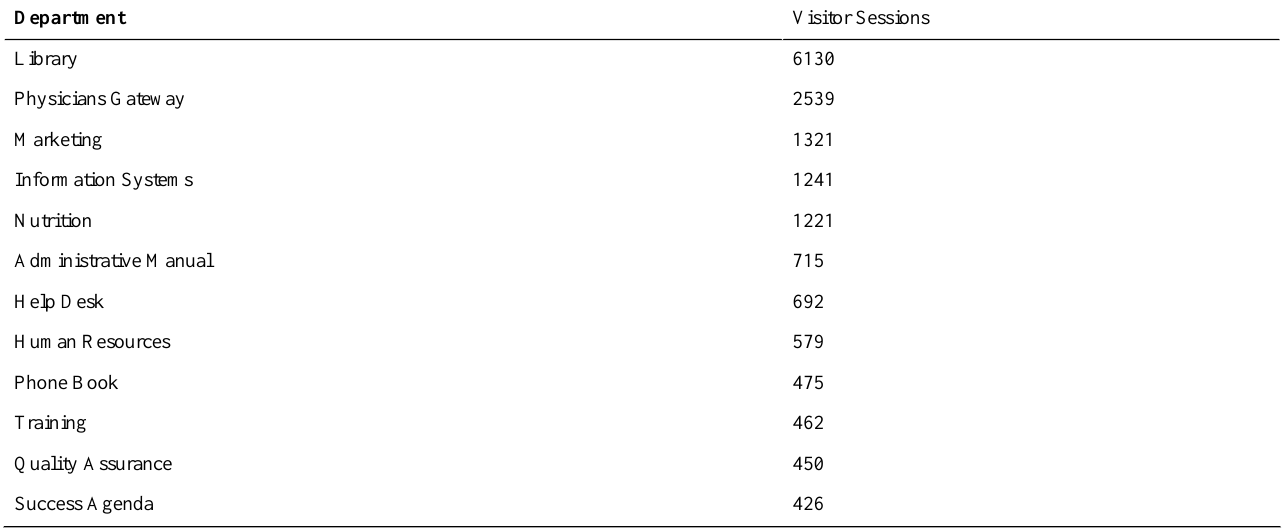
Table 2. Departments Receiving the Most Visitor